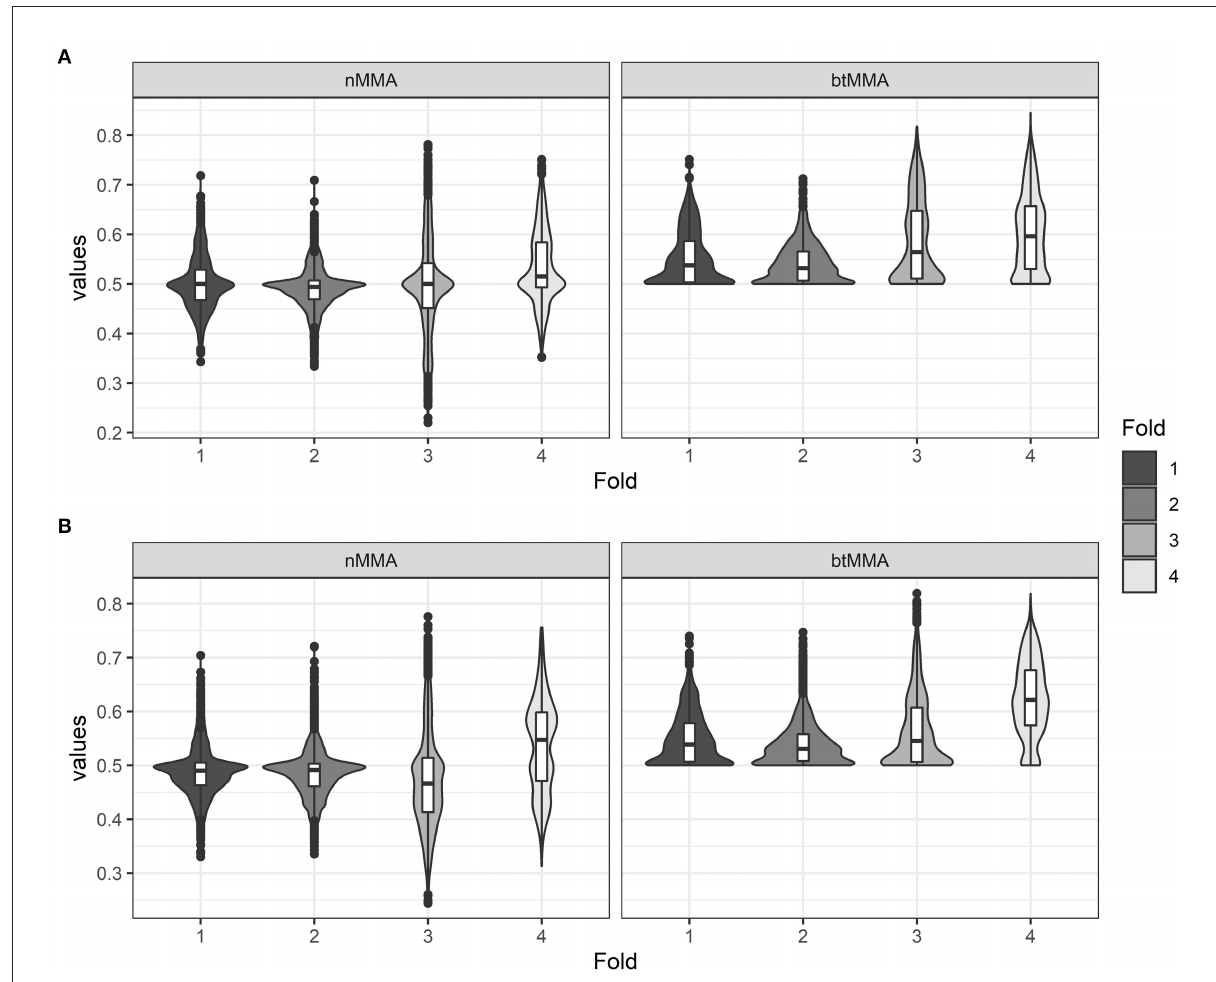
FIGURE3 Violin plots showing the values for the varying performance metrics (nMMA: naïve major-mean accuracy, btMMA: best-threshold major-mean accuracy) for the LSTM network (A) and the CNN network (B) across the four folds of the cross-validation.